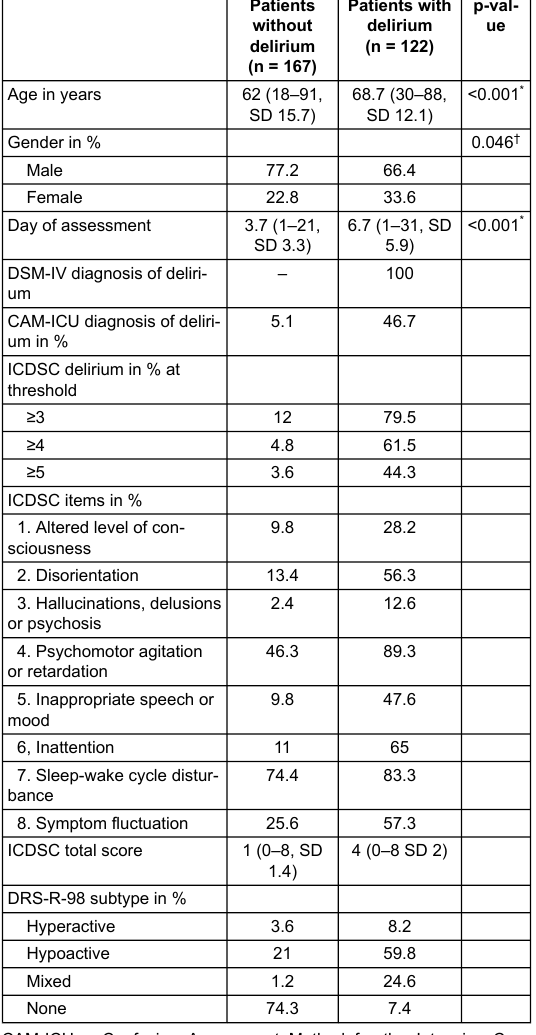
Table 1: Sociodemographic and medical characteristics of patients without versus those with delirium as determined by DSM-IV-TR.